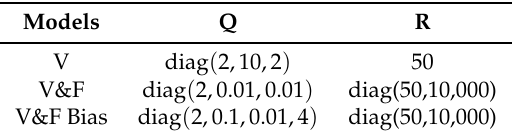
Table 2. Control weights for the different sensors using the simulated data. V, terminal voltage; V&F, fusion of both sensors; V&F Bias, fusion of both sensors with bias